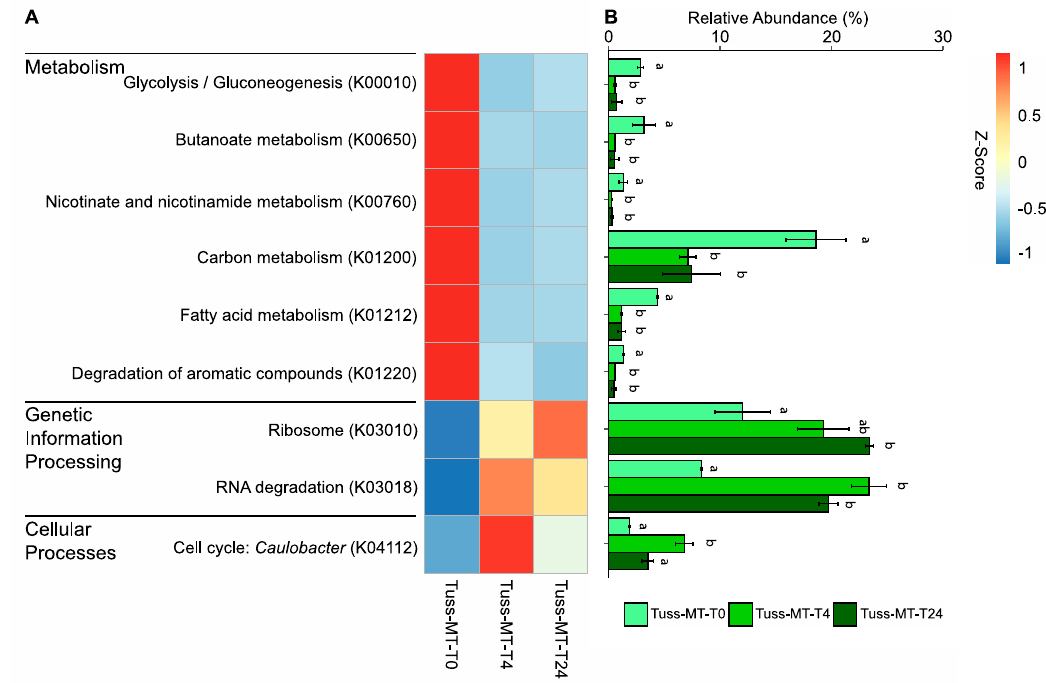
Figure 4. Heatmap ( A ) and barplot ( B ) of microbial gene expression between sampling time points within tussock tundra based on the mean relative abundance of TPM-normalized metatranscriptome (MT) gene transcripts belonging to KEGG tier IV functional pathways. Z-score transformations based on the mean relative abundance of transcripts between sampling time points. Error bars for each barplot represent standard deviation from the mean. Letters indicate significant differences in mean pairwise similarity between sampling time points in each KEGG tier IV category (ANOVA; p < 0.05).